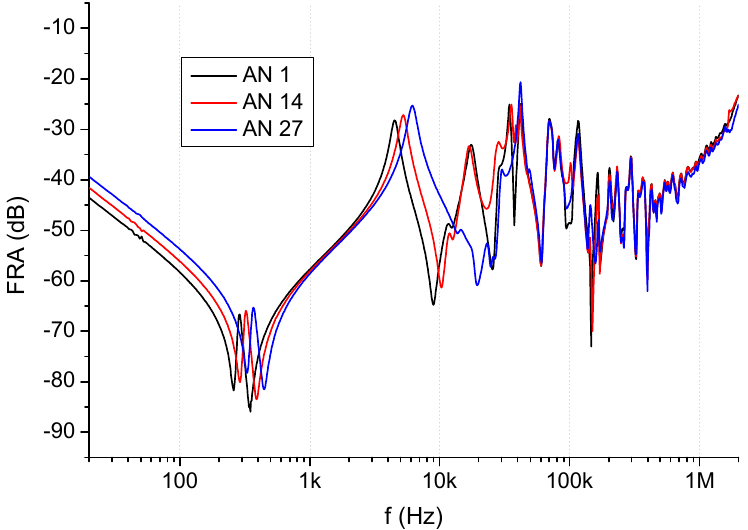
Figure 11. FR of phase A of 160 MVA, 220/110/15 kV autotransformer for three positions of OLTC.